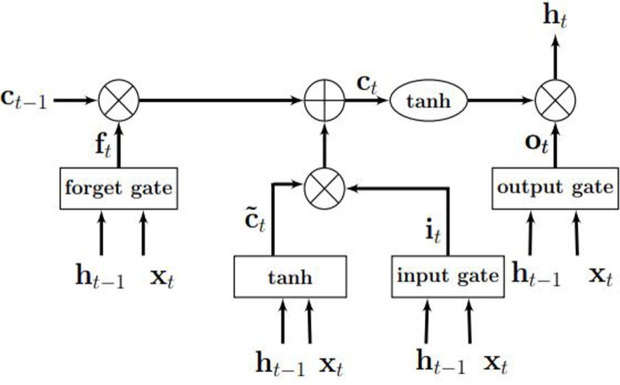
An illustration of an LSTM memory cell. Source: Gupta and Dinesh (2017).